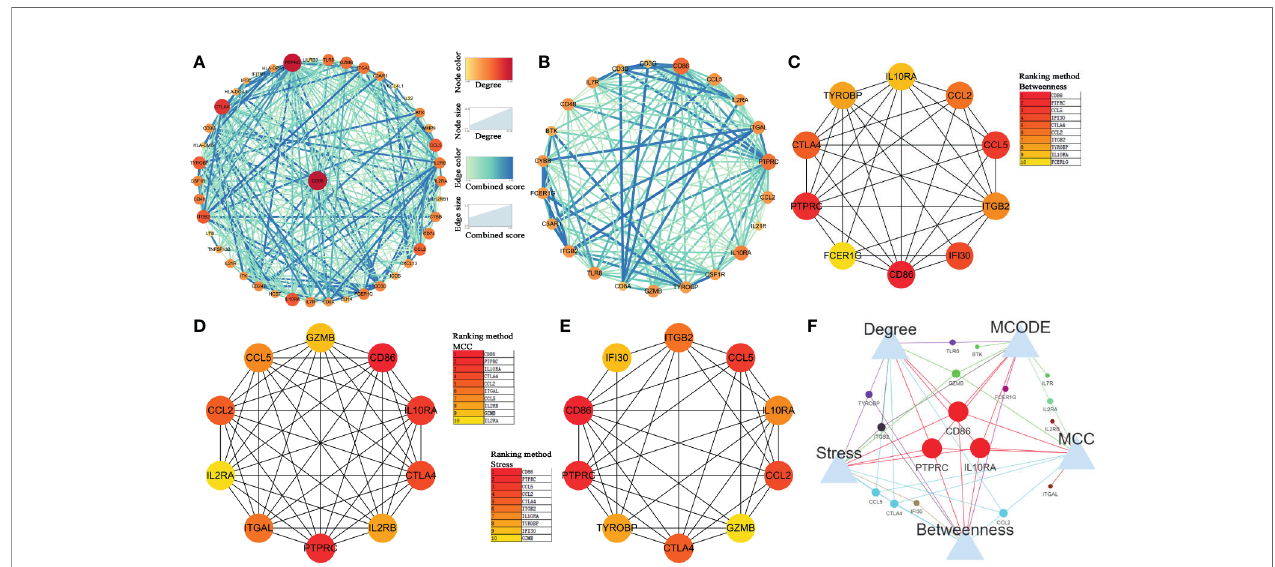
FIGURE 4 | Identi fi cation of hub genes. (A) Protein-protein interaction (PPI) network of hub genes in key modules. (B) Top 1 module via MCODE. (C) The network of top 10 hub genes screened by CytoHubba Betweenness algorithm. (D) The network of top 10 hub genes screened by CytoHubba MCC algorithm. (E) The network of top 10 hub genes screened by CytoHubba Stress algorithm. (F) Venn diagram to screen out overlapped hub